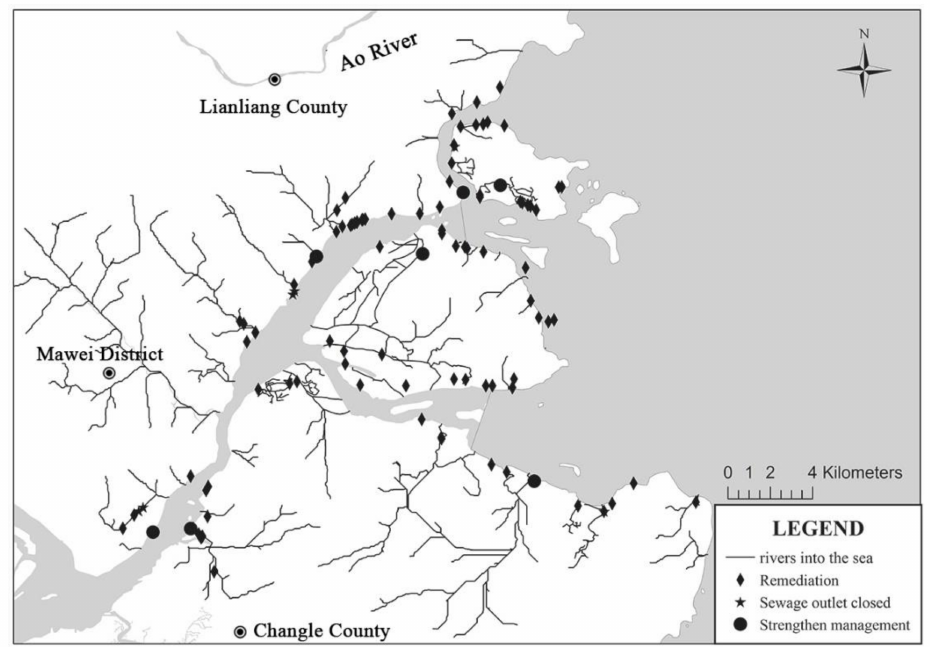
Figure 9. Distribution of sewage outfalls for the rectification in the Minjiang